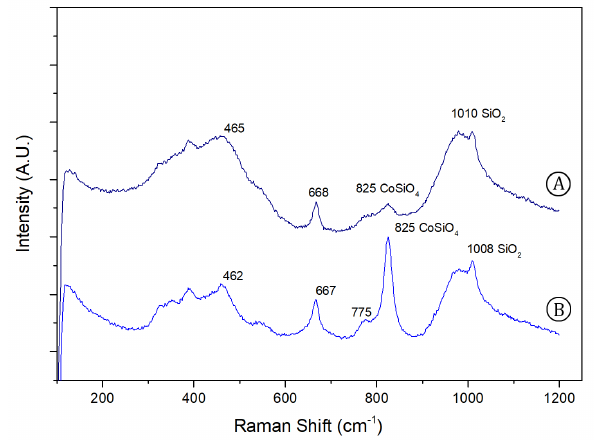
Figure 5. Recorded µ -Raman spectra for blue glazed regions: ( A ) vitreous blue region, ( B ) darker blue region; ( B ) λ excitation = 532